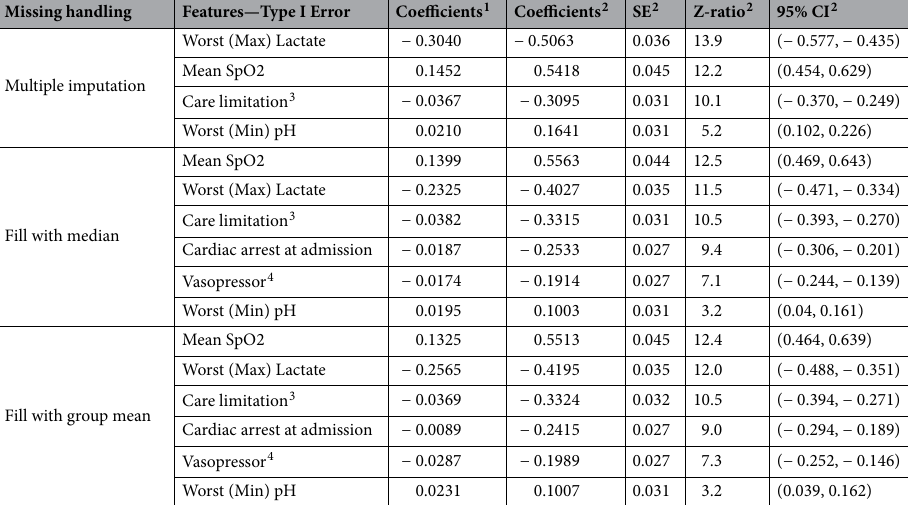
Table 5. Features selected for Type I error when using cutoff 0.33, with ARC removed. 1 Coefficients calculated from fitting the Lasso feature selection model. 2 Coefficients, SE, Z-ratios, and the 95% CIs calculated by ordinary logistic regression using the selected features from Lasso; Features sorted by Z-ratios, where Z-ratio = | Coefficient / SE | . 3 Care Limitation is how often the care limitation(s) recorded in the care planning was required to change for the patient. 4 Whether vasopressor was provided to the patient within the first 24 h.